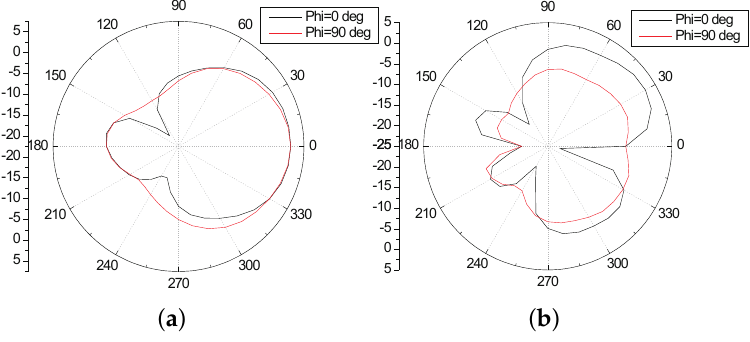
Figure 23. The directional pattern of the improved antenna ( a ) 2.43 GHz; ( b ) 5.2